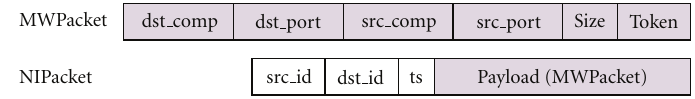
Figure 6: Structure of packets at the NI and middleware levels (src id: source tile, dst id: destination tile, ts: timestamp, dst comp: destination component, dst port: destination port, src comp: source component, and src port: source port).